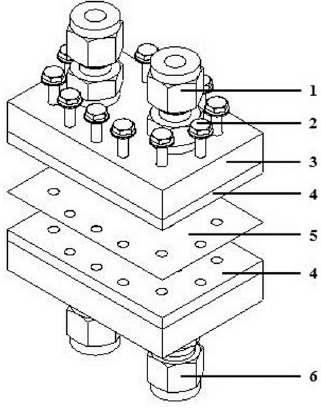
Figure 1. Exploded view CAD drawing of the gas-to-gas micro heat exchanger: (1) gas inlet, (2) screws, (3) cover plates, (4) plates with microstructures, (5) partitioning foil, and (6) gas outlet. The plates with microstructures were generated with mechanical micro machining from aluminum. Rectangular pin fin shapes in parallel and staggered arrangement were compared with straight micro channels, as shown in Figure 2.